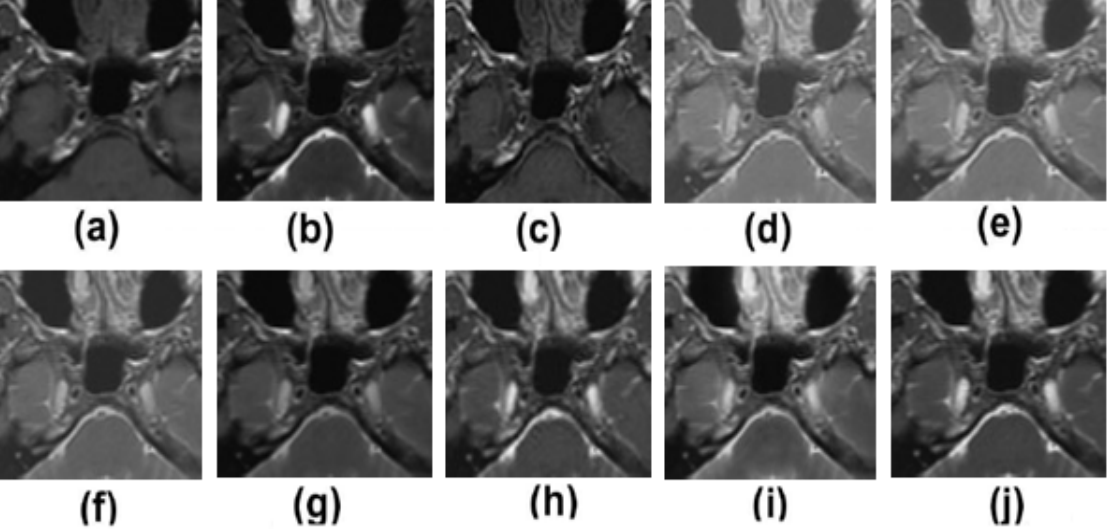
Figure 5. Zoomed results of multimodality medical image fusion; ( a ) input multimodality medical image 1; ( b ) input multimodality medical image 2; ( c ) Zhang et al. [12]; ( d ) Ramlal et al. [13]; ( e ) Dogra et al. [14]; ( f ) Ullah et al. [15]; ( g ) Huang et al. [16]; ( h ) Liu et al. [17]; ( i ) Mehta et al. [18]; ( j ) proposed method.